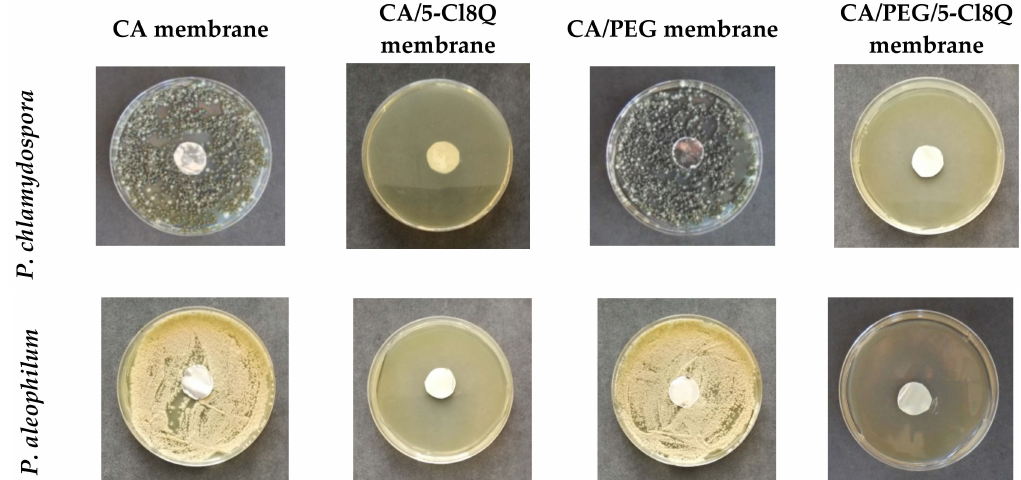
Figure 6. Digital images of the zones of inhibition against P. chlamydospora and P. aleophilum after the contact of the membranes with fungi cells. The membrane type is indicated at the top of each column. The cell type is marked on the left of each row.